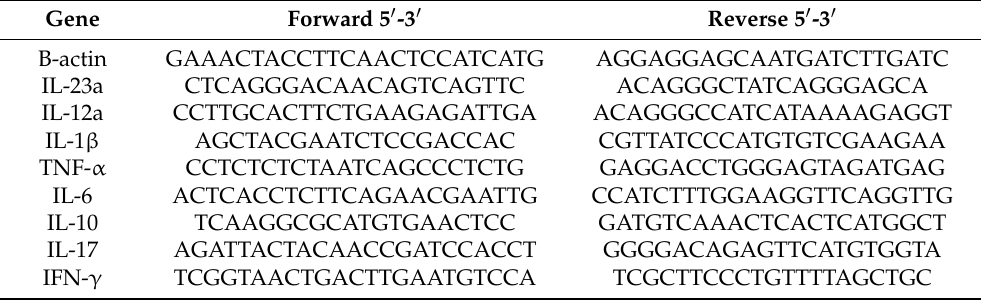
Table 2. Primers used in this